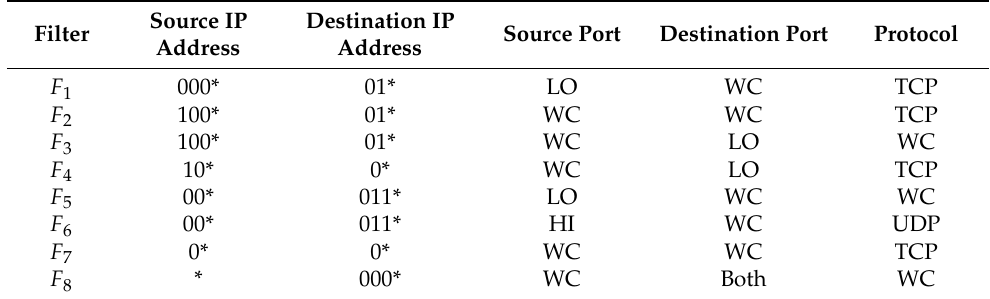
Table 6. After classification based on each non-prefix field value in Table